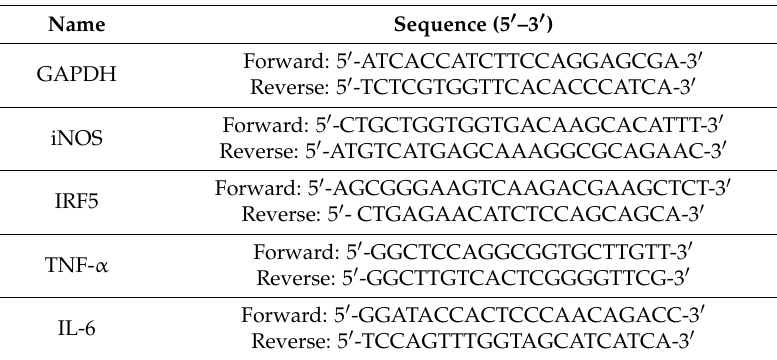
Table 1. Sequences of primers used in